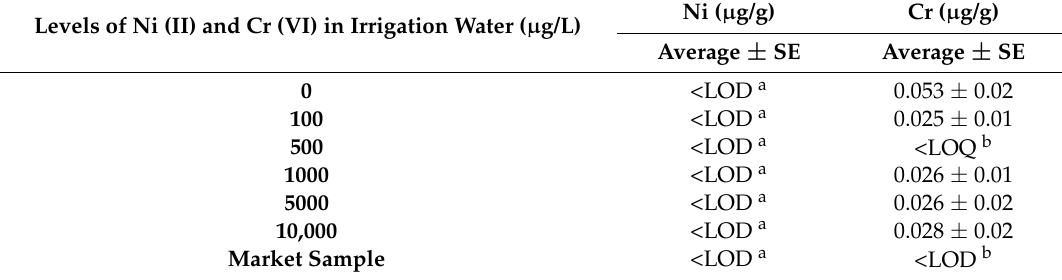
Table 3. Levels of nickel and chromium in sunflower oils.